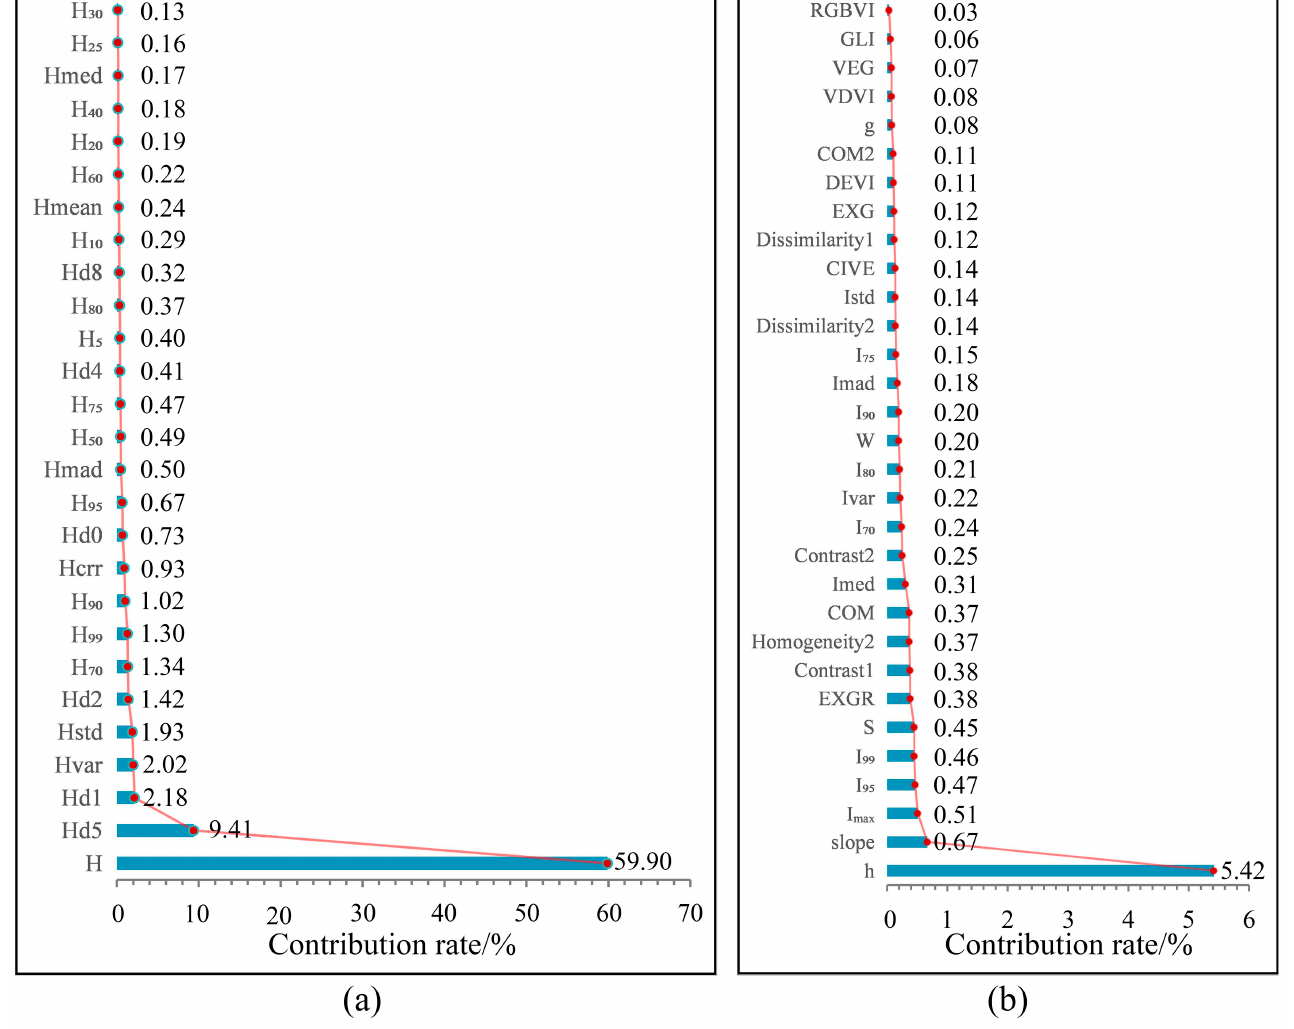
Figure 11. Importance of random forest characteristic variables. Using a python script, the importance analysis of all variables involved in the construction of the forest volume estimation model was performed in the random forest algorithm; each variable was scored in order of its contributory magnitude and ( a ) shows the score ranking of variables associated with the height of point cloud, while ( b ) shows the score ranking of other variables.